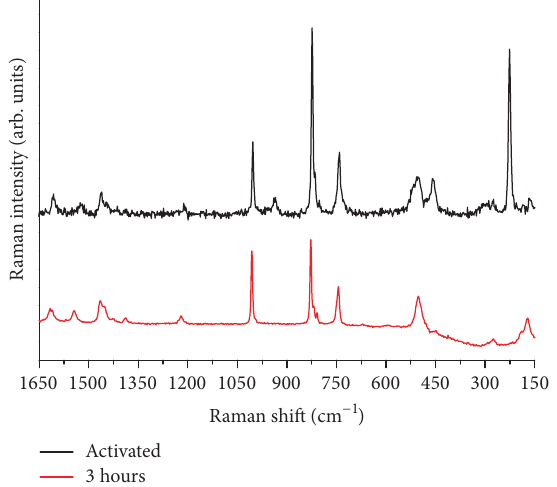
Figure 2: High resolution Raman spectra of the HKUST-1 sample activated (black line) and after about 3 hours of exposure to air moisture at 𝑇 = 300 K (red line). Spectra are vertically shifted, for viewing purposes, after the normalization described in the text.